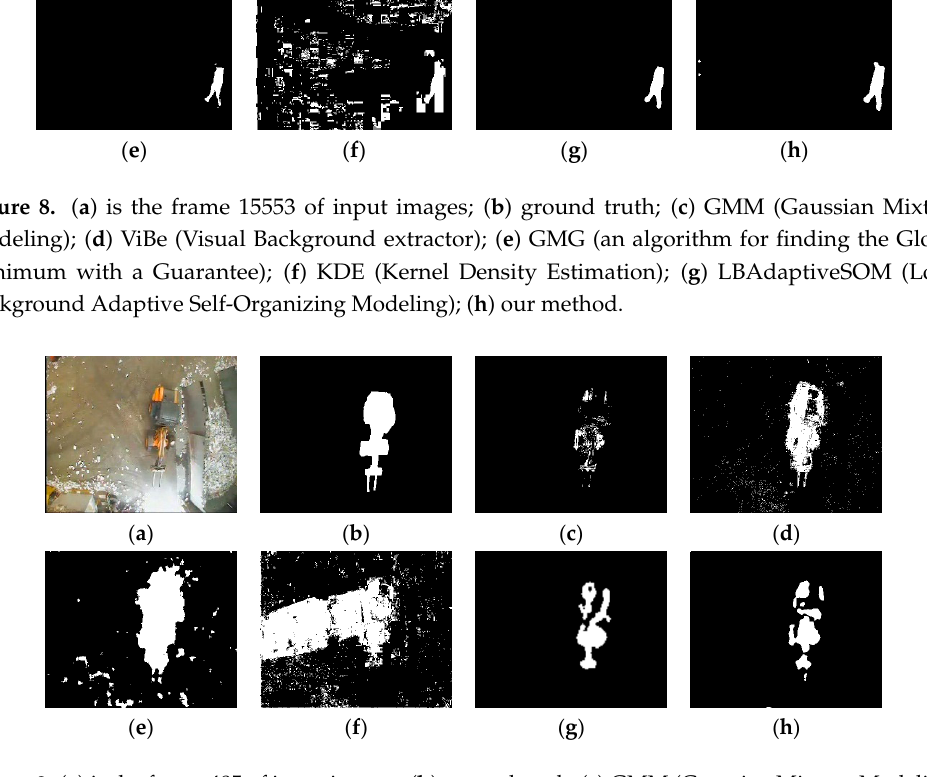
Figure 9. ( a ) is the frame 485 of input images; ( b ) ground truth; ( c ) GMM (Gaussian Mixture Modeling); ( d ) ViBe (Visual Background extractor); ( e ) GMG (an algorithm for fi nding the Global Minimum with a Guarantee); ( f ) KDE (Kernel Density Estimation); ( g ) LBAdaptiveSOM (Local Background Adaptive Self-Organizing Modeling); ( h ) our method.